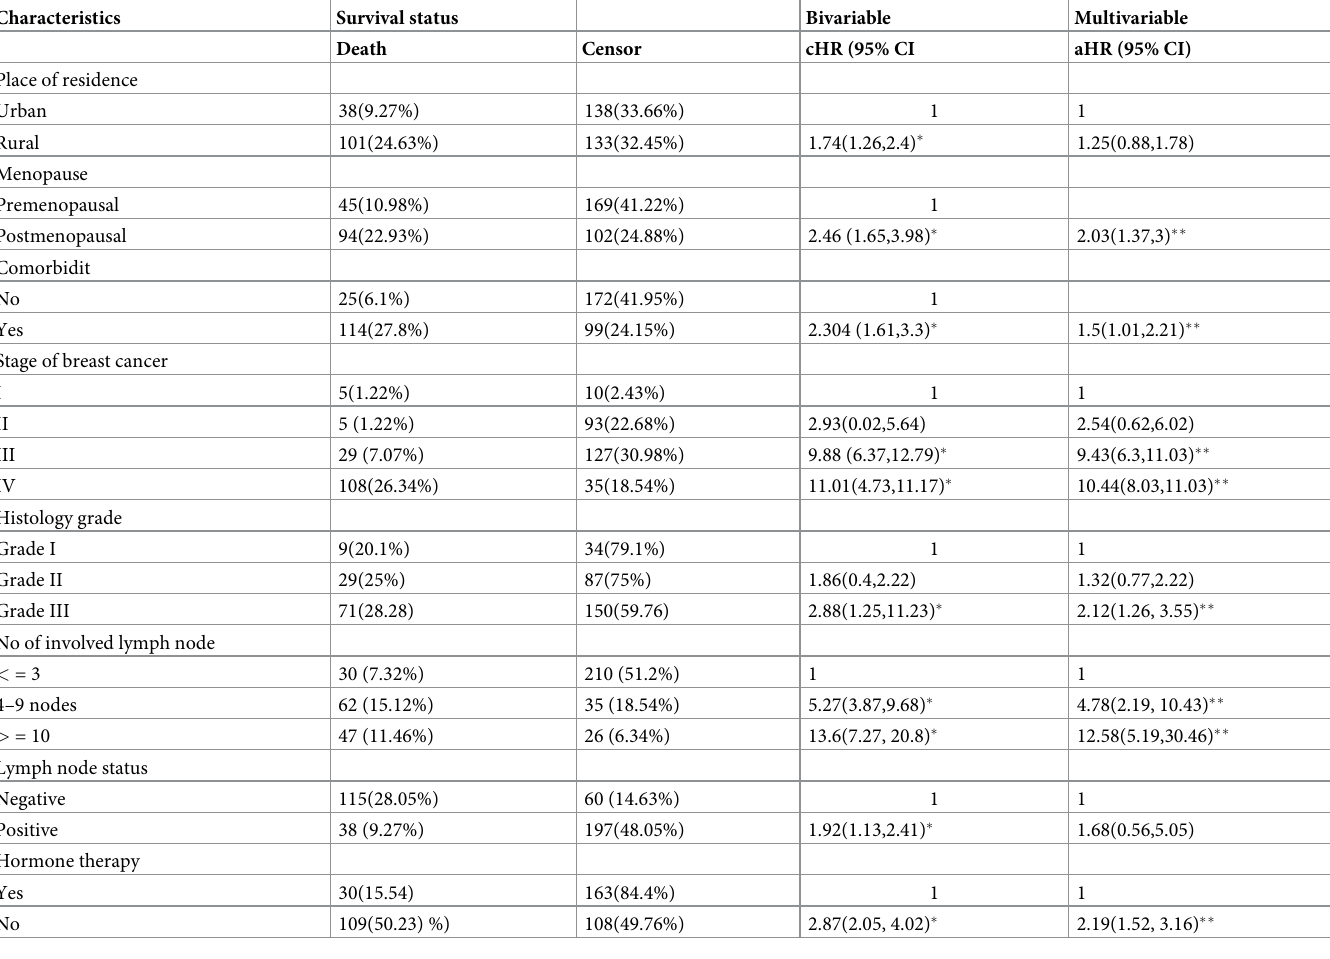
Table 4. Bivariable and multivariable Cox regression analysis for predictors of mortality among breast t cancer patients in UOGCSRH from February 2015 to Feb- ruary